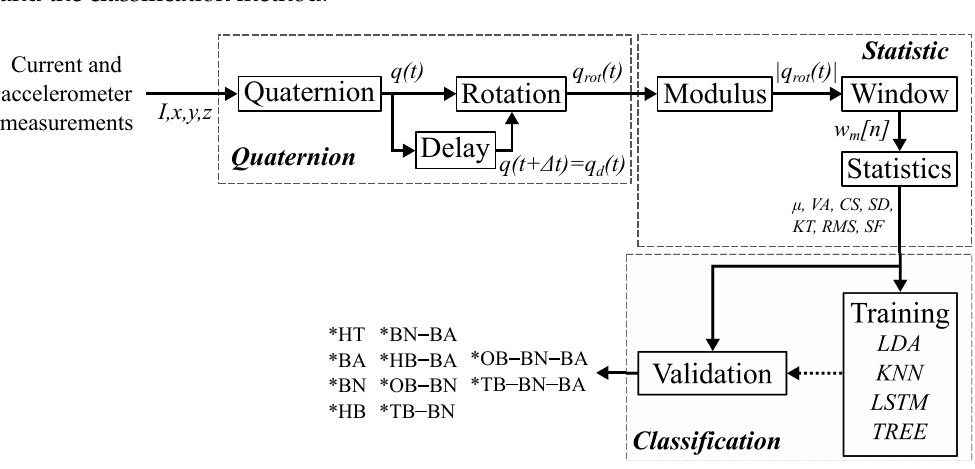
Figure 1. Flowchart of the proposed methodology, where current and acceleration signals are gotten into and single and combined classes are